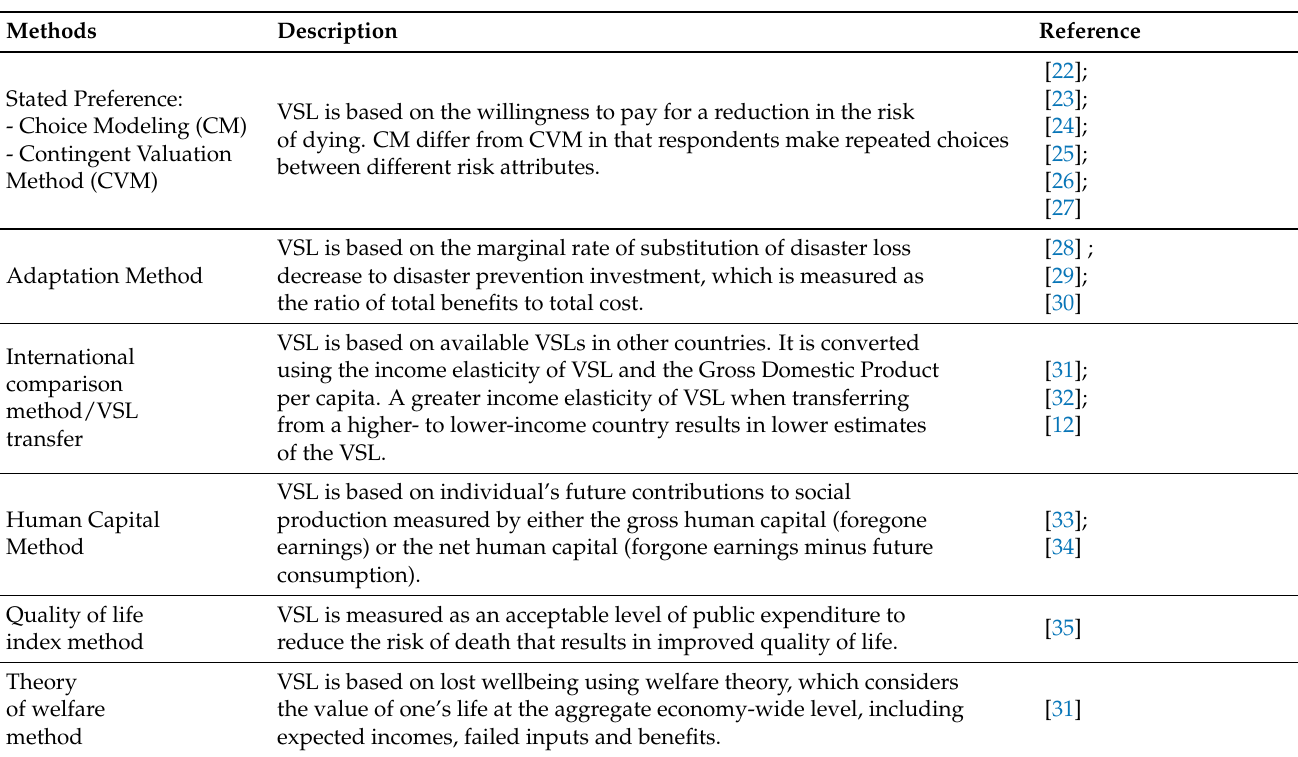
Table 1. Value of statistical life estimation